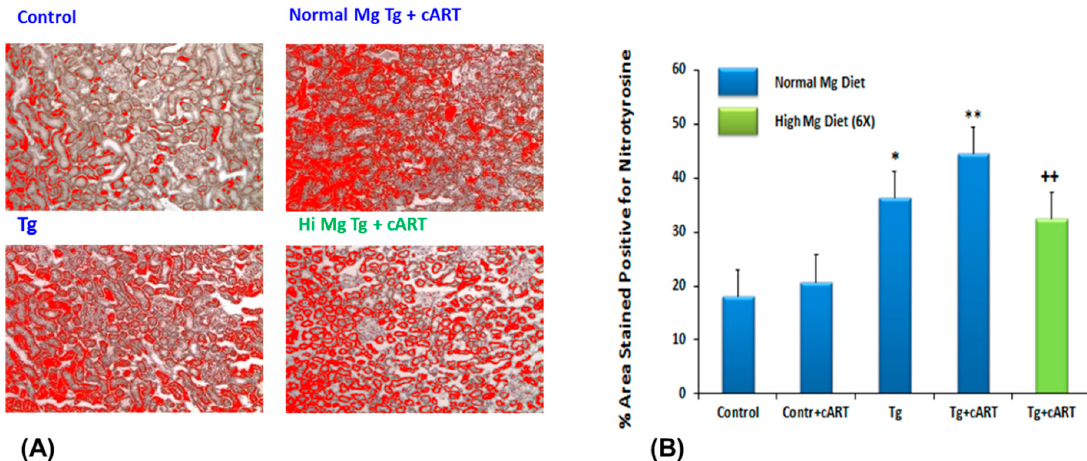
Figure 8. Micrographs showing immunohistochemical staining for 3-nitrotyrosine (NT) in kidneys of Ctl and HIV-1 Tg ± cART ± Mg supplemented (Hi Mg) rats (18 weeks) ( A ). NT staining is selected with red color in the ImageJ program used for quantification and is pre-dominant in kidney cortex; % area stained positive for NT of Tg ± cART ± Mg supplemented rats ( B ). Values are means ± SE = 5 rats/group. * p < 0.5; ** p < 0.001 vs. Ctl; ++ p < 0.02 vs. Mg-normal Tg + cART.